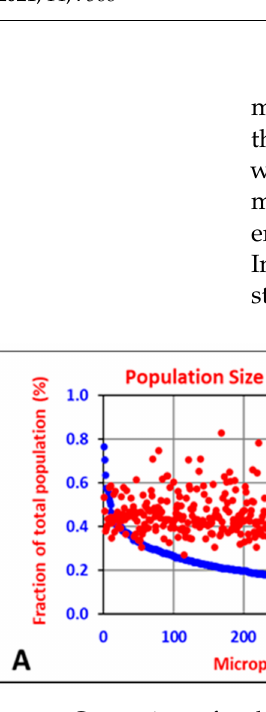
Figure 2. Comparison of ranked population strengths (percentage of total micropolitan population, blue dots) of micropoli- tans with ( A ) the strength of their tourism enterprises (percentage of total tourism enterprises, red dots) and ( B ) the strength of their manufacturing enterprises (percentage of total manufacturing enterprises, red dots).